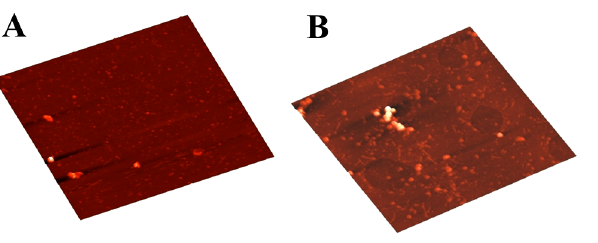
Fig. 4. Differential oligomerization of C-214-HrpZ Pss and full length HrpZ Pss studied by AFM. C-214- HrpZ Pss forms non specific aggregates ( A ), whereas full length HrpZ Pss is characterized by the formation of both non-specific and fibrillar aggregates ( B ). Scale bar: 0.5 m m.